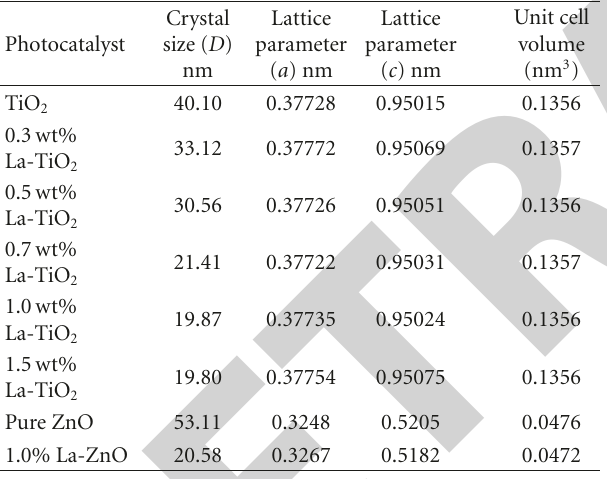
Figure 1: XRD patterns of TiO 2 and La-doped TiO 2 : (a) TiO 2 , (b) 0.5wt%, (c) 0.7wt%, (d) 1.0 wt%, and (e) 1.5 wt% La-doped TiO 2 . Table 1: Physicochemical characteristic of TiO 2 and La-doped TiO 2 photocatalysts.